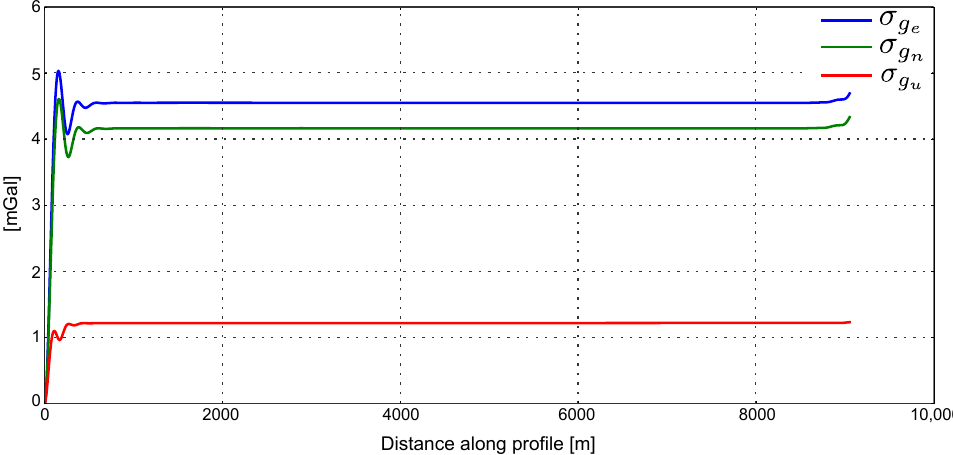
is almost four times u